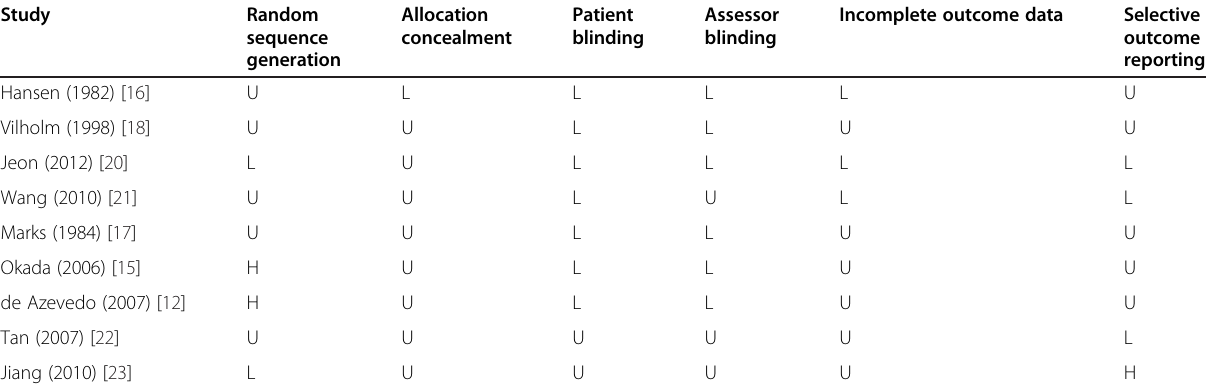
Table 3 Risk of bias of included RCTs *